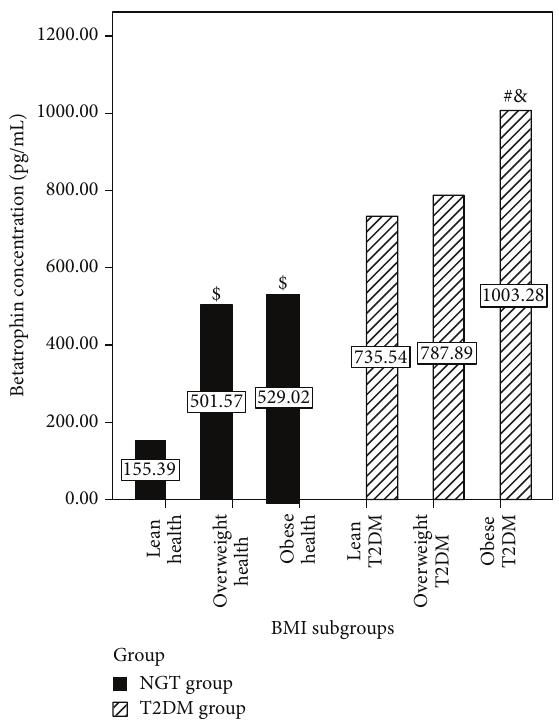
Figure 1: Serum betatrophin concentrations in each subgroup. Serum betatrophin concentration in NDM group: lean health ( 𝑛 = 18 ), overweight health ( 𝑛 = 22 ), and obese health ( 𝑛 = 18 ). Type 2 diabetes group: lean T2DM ( 𝑛 = 22 ), overweight T2DM ( 𝑛 = 29 ), and obese T2DM ( 𝑛 = 22 ). Data are mean ± SEM; $ 𝑃 < 0.05 versus lean health; # 𝑃 < 0.05 versus lean T2DM; & 𝑃 < 0.05 versus overweight